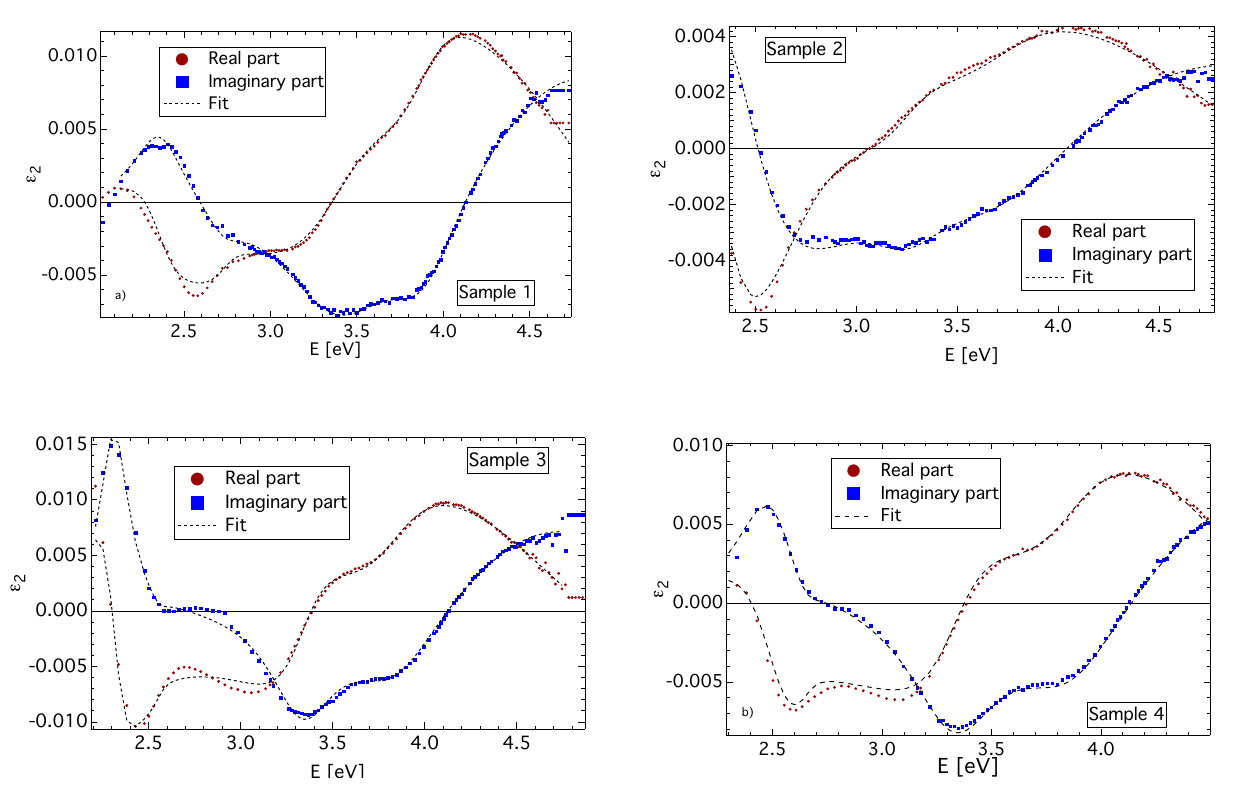
Figure 4. The off-diagonal elements, ε measurements along with the fitted theoretical